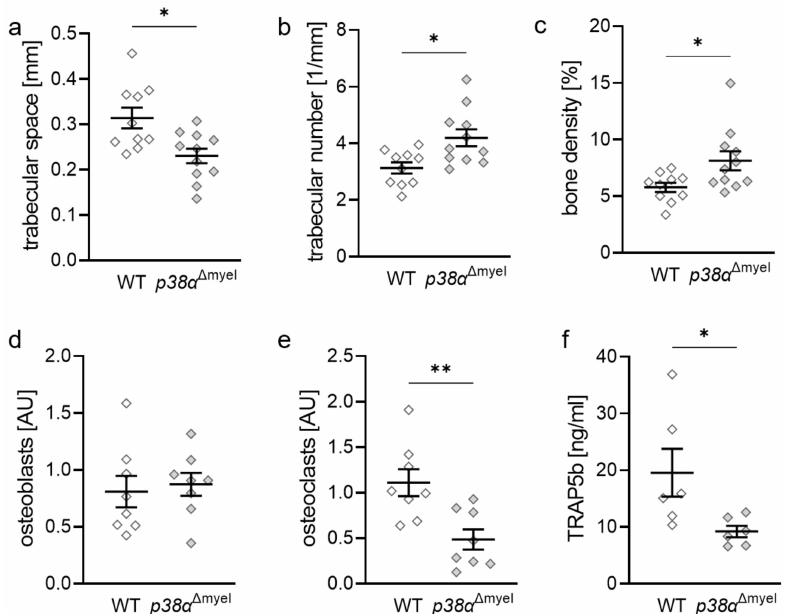
Figure 2. Bone parameter in tibia ( n ≥ 8) and TRAP5b in serum ( n = 6) of wildtype (WT) and p38 ∆ myel mice. Trabecular number ( a ), trabecular space ( b ), and bone density ( c ) were obtained by µ CT analysis. Osteoblast ( d ) and osteoclast ( e ) number were determined by histological staining. TRAP5b ELISA ( f ) showed reduced levels in serum of p38 α ∆ myel mice. Each symbol respresents one data point. The horizontal line represents the mean value and the vertical lines represent the standard error. Statistics: Mann–Whitney U test; * p < 0.05; ** p <